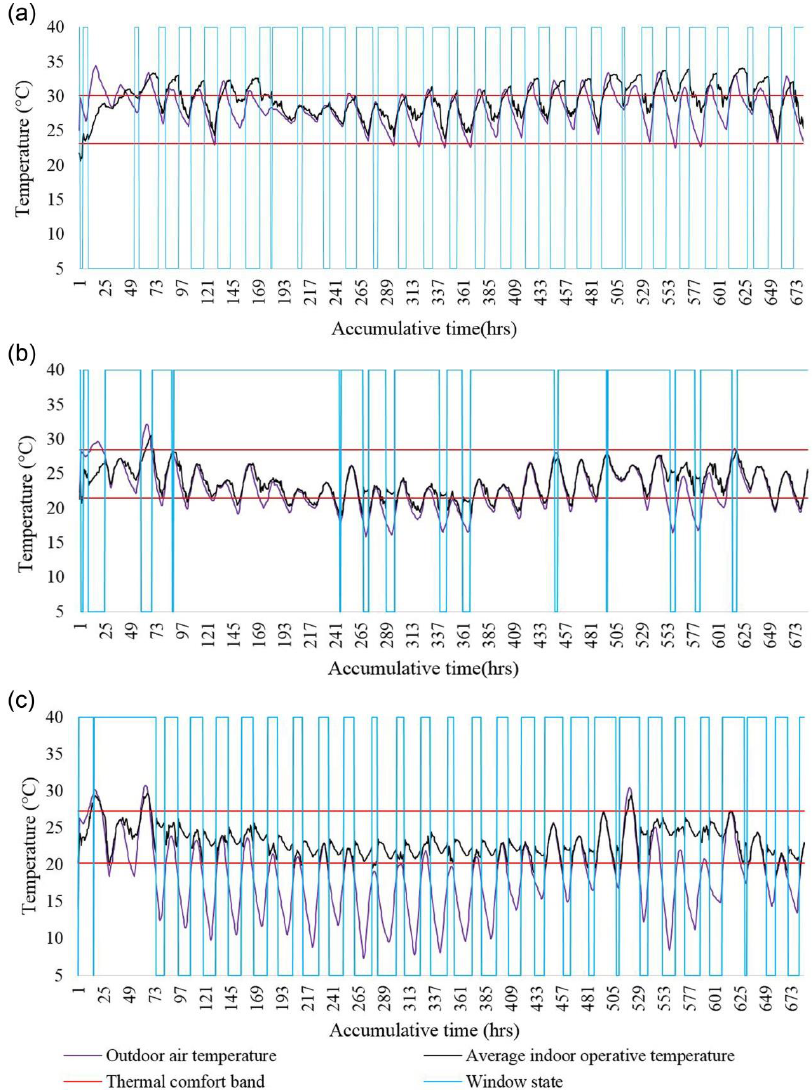
Figure 8. Indoor operative temperature variation during January in: ( a ) Darwin; ( b ) Sydney; and ( c )